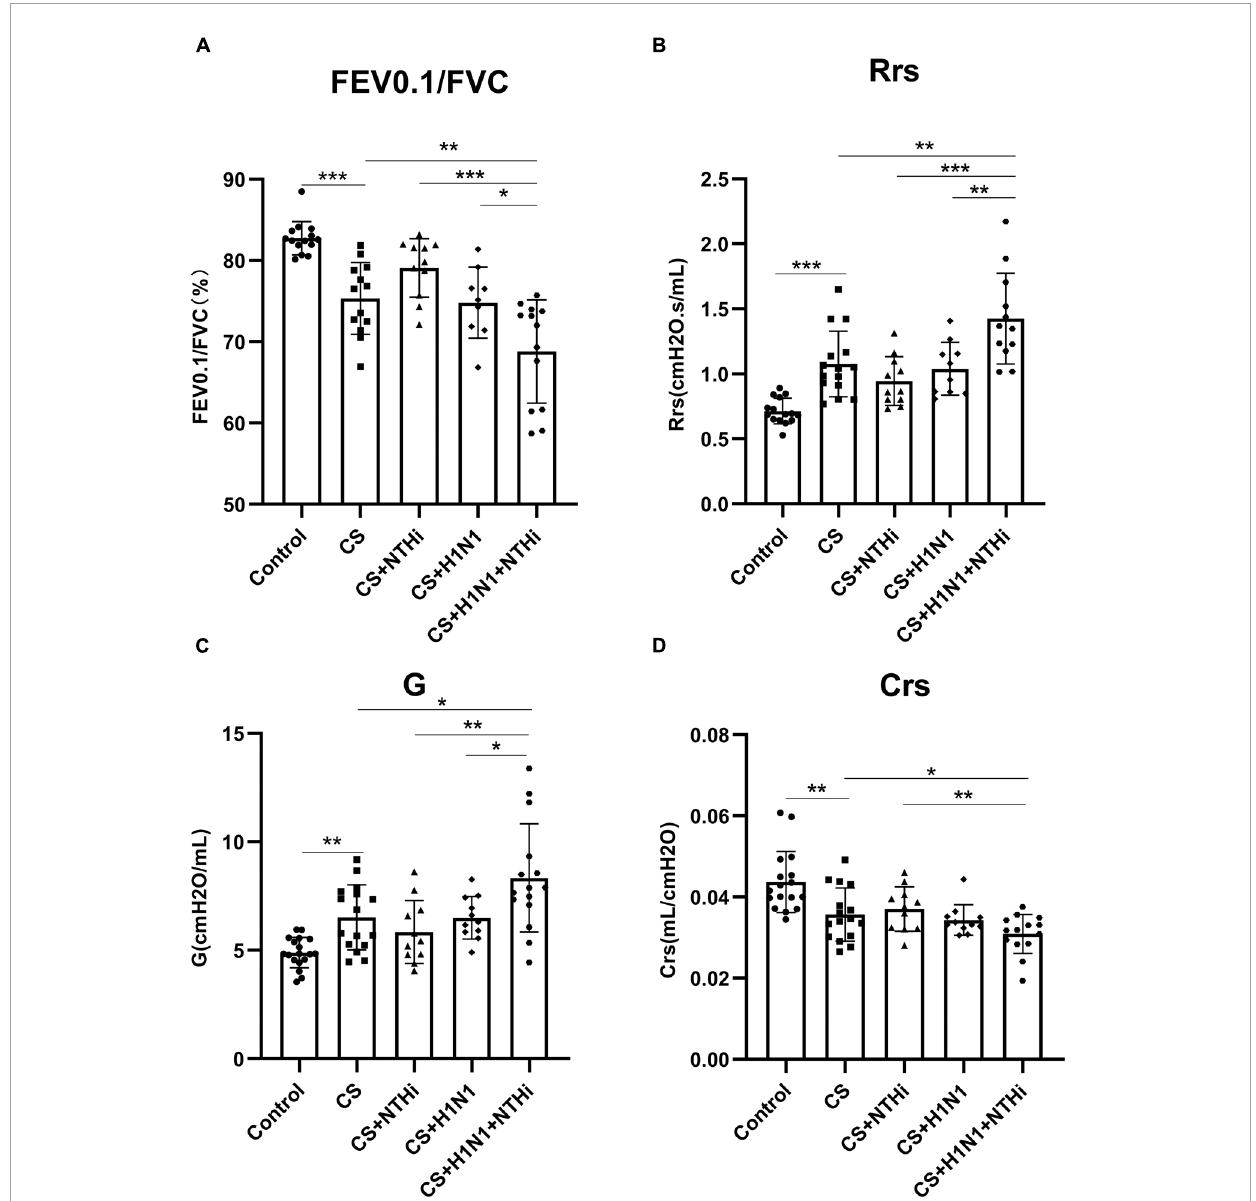
FIGURE4 Coinfection with PR8 and NTHi impaired invasive lung function in AECOPD mice. At 24 h after NTHi challenge, invasive lung function was measured by forced expiratory volume in 0.1 s/forced vital capacity (FEV0.1/FVC) (A) , respiratory resistance (Rrs) (B) , tissue damping (G) (C) , and respiratory system compliance (Crs) (D) . Data are expressed as mean ± SD ( n = 10–15). * p < 0.05, ** p < 0.01, and *** p <